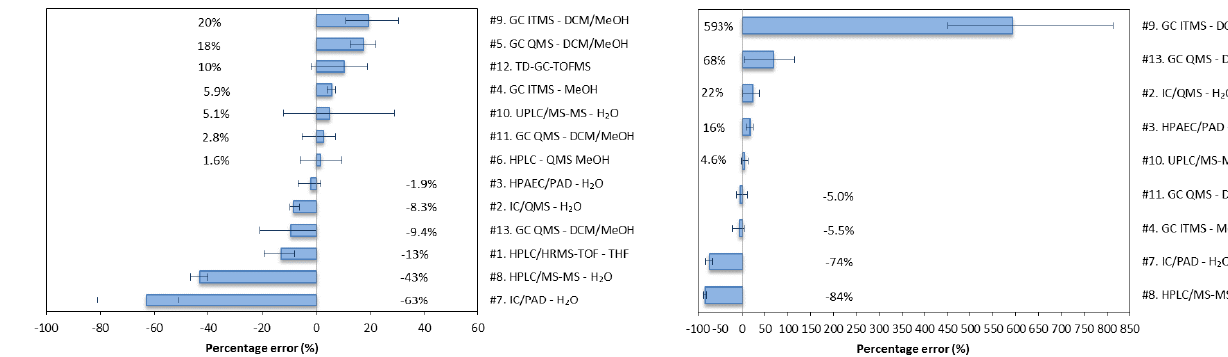
Figure 4. Calculated mean percentage error (PE) for each of the Figure 4: Calculated mean percentage error (PE) for each of the nine laboratories reporting nine laboratories reporting levels of galactosan in the current inter- levels of galactosan in the current intercomparison. The PE was calculated according to eq. 1 comparison. The PE was calculated according to Eq. (1) (Sect. 2.5) (Section 2.5) for each of the six sectors received by the participating laboratories. The mean PE for each of the six sectors received by the participating laboratories. for each laboratory accounts for the PE calculated for all of the six sectors. The laboratory The mean PE for each laboratory accounts for the PE calculated for number, ranging from 1-13, the analytical method and solvent used for extraction are mentioned all six sectors. The laboratory number, ranging from 1–13, the ana- at the right in the figure. lytical method and solvent used for extraction are mentioned at the right in the